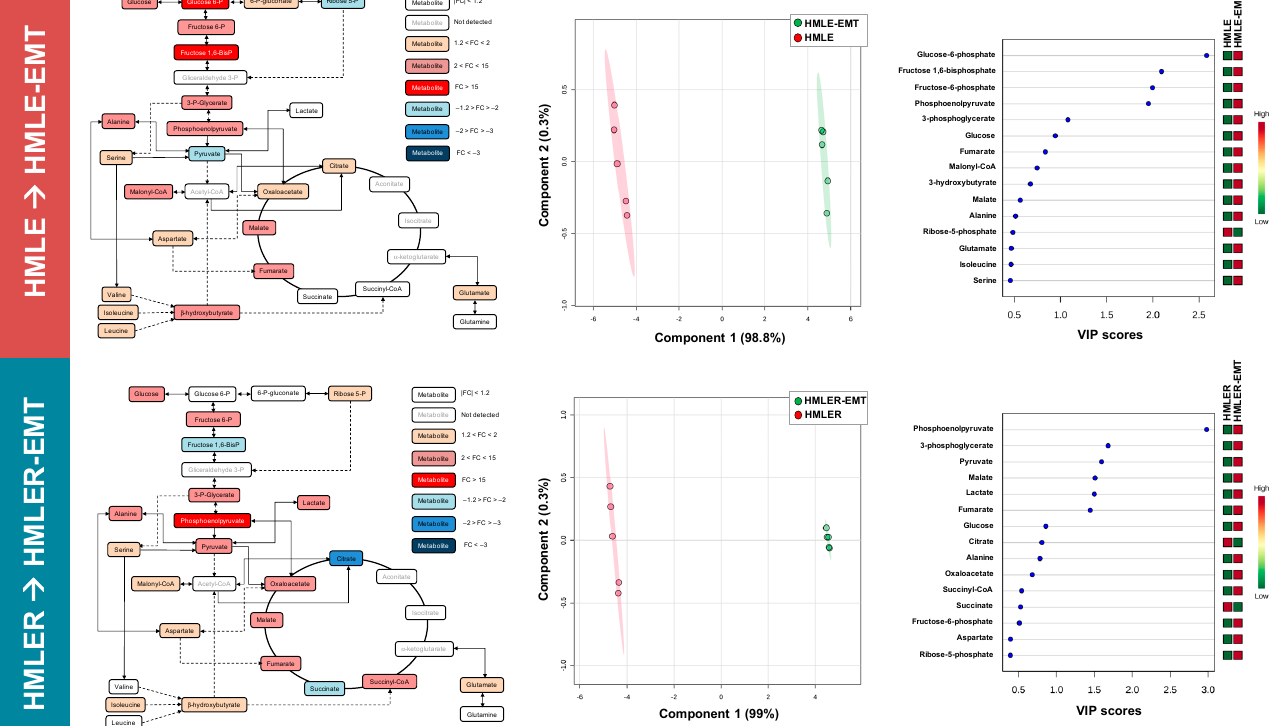
Figure 3. Bioenergetic fingerprints of non-tumorigenic and tumorigenic EMT (I). Left panels: Bioenergetic metabolites from non-tumorigenic HMLE-EMT and tumorigenic HMLER-EMT mesenchymal cells were extracted and quantitatively analyzed by GC-EI-QTOF-MS and compared with those in non-tumorigenic HMLE and tumorigenic HMLER parental counterparts. Significantly increased and decreased metabolites (EMT vs. epithelial controls) are shown using brown-red and light blue-dark blue color scales, respectively. Middle panels: Two-dimensional score plots of the partial least square discriminant analysis (PLS-DA) models of the GC-EI-QTOF-MS-based bioenergetic metabolomic profiling of HMLE/HMLE-EMT and HMLER/HMLER-EMT cells. The X and Y axes represent the combinations of the different bioenergetic metabolites analyzed, showing the maximum separation between groups. Right panels: Key bioenergetic metabolites separating the metabolomic profiles of HMLE/HMLE-EMT and HMLER/HMLER-EMT cells based on variable importance in projection (VIP) in PLS-DA analysis described in the middle panels. The VIP score, which is calculated as a weighted sum of the squared correlations between PLS-DA components and the original variable, summarizes the contribution of the metabolites’ importance in the PLS-DA model. The number of terms in the sum depends on the number of PLS-DA components found to be significant in distinguishing the classes.